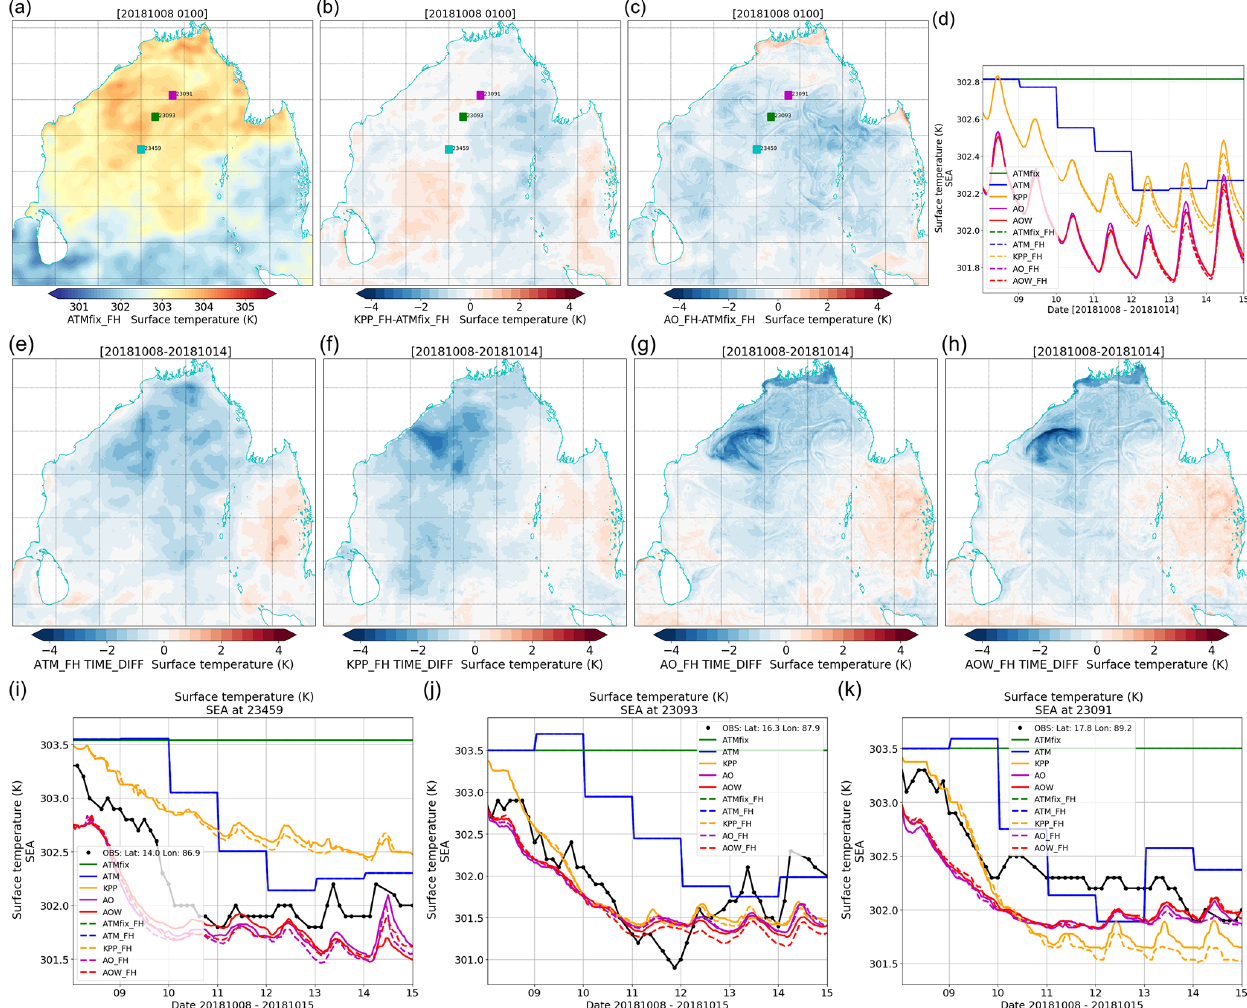
Figure 3. (a) Constant SST field in ATMfix(_FH) control simulation, based on OSTIA data available for forecasting at 00:00UTC on 8 October 2018 for simulations of cyclone Titli (note central scale value of 303K is approximately 30 ◦ C), and (b, c) initial-condition difference in SST for (b) KPP and (c) AO (and AOW) simulations. Note that ATMfix and ATM use same SST on the first day of simulations, and that initial conditions are common to each experiment with/without frictional heating. (d) Time series of regional mean SST for each experiment during the 7d Titli case study, for the sub-domain shown in (a) . (e–h) Difference in SST for ATM_FH, KPP_FH, AO_FH and AOW_FH simulations respectively at run final time compared to run start time, illustrating extent and magnitude of cooling during each simulation. (i, j, k) Comparison of time series of SST from each experiment with in situ ocean buoy observations at 23459, 23093 and 23091 respectively. Model data are taken as means in 5 × 5 grid neighbourhood surrounding each buoy location (shown in Fig. 1 and panel a – c ). Simulations without frictional heating are shown as solid lines, with frictional heating with dashed lines.